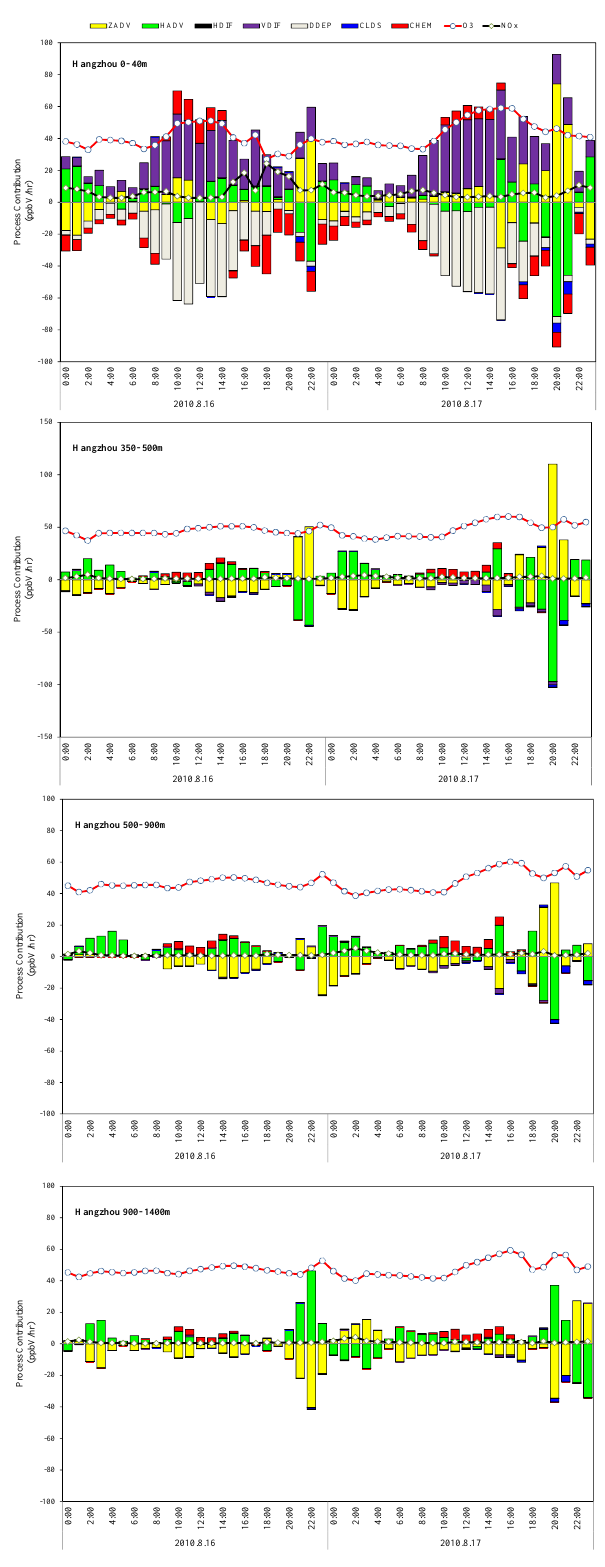
Fig.14. Atmospheric processes contribution to net O 3 density at Hangzhou site during August 16--17, Fig. 14. Atmospheric processes contribution to net O 3 density at 2010. Hangzhou site during 16–17 August Figure 15 shows the emission inputs of NO x and the main VOC species at the Hangzhou site. It can be